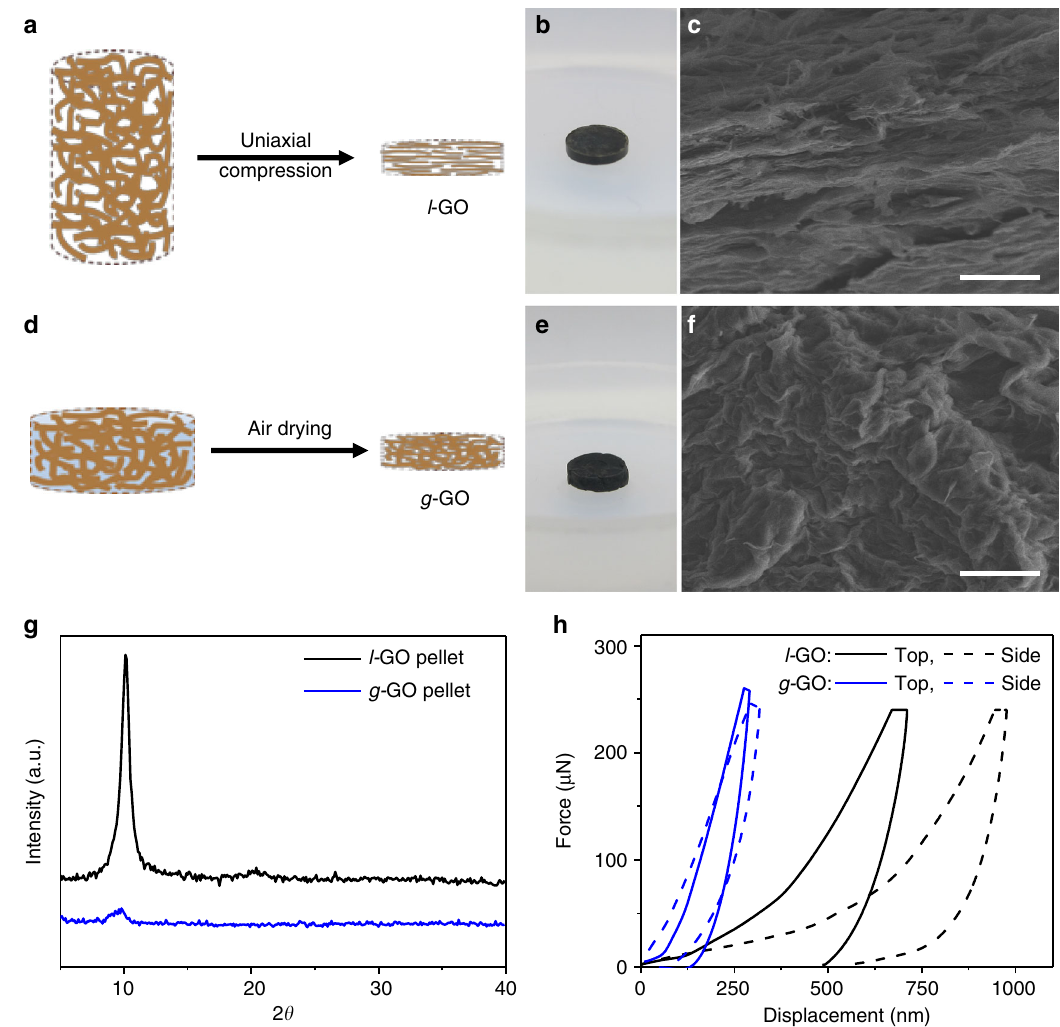
Fig. 6 Glassy GO solid with enhanced and isotropic mechanical properties. a – c Uniaxial compression turns a freeze-dried GO foam to a GO pellet with lamellar microstructure, which is denoted as l -GO. d – f A glassy GO pellet made of disorderly packed sheets, denoted as g -GO, is made by fi rst gently molding the dough into a pellet by hand, followed by drying in air. g XRD patterns and h nanoindentation curves of the two types of GO pellets. The g -GO pellet does not have a strong diffraction peak corresponding to lamellar ordering, and exhibits largely isotropic properties and higher hardness. Scale bars in c and f are 10 μ